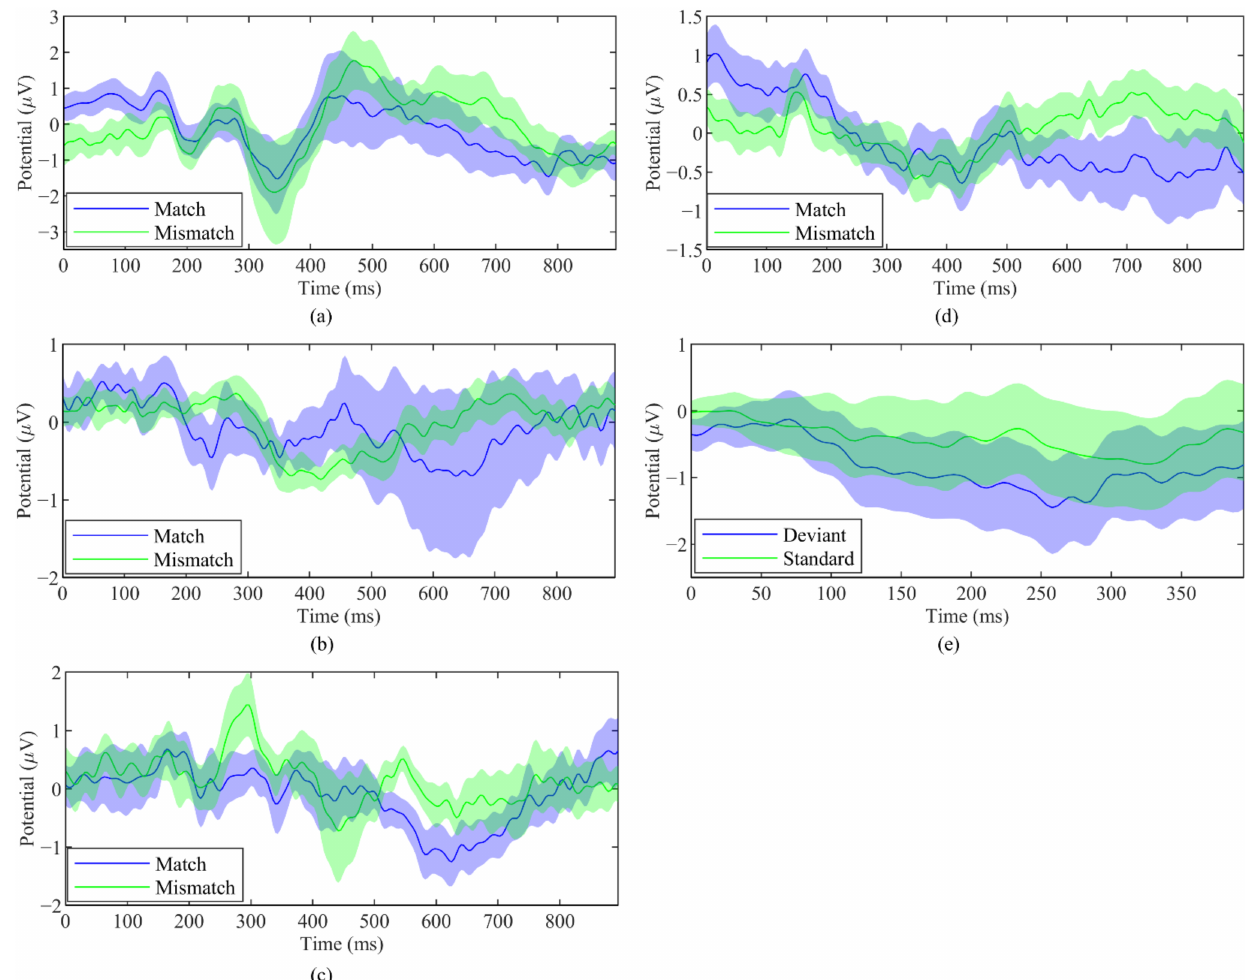
Figure 6. Grand-average waveforms with standard error at Pz ( a ) Method 1a; ( b ) Method 1b; ( c ) Method 1c; ( d ) Method 2; ( e ) Method